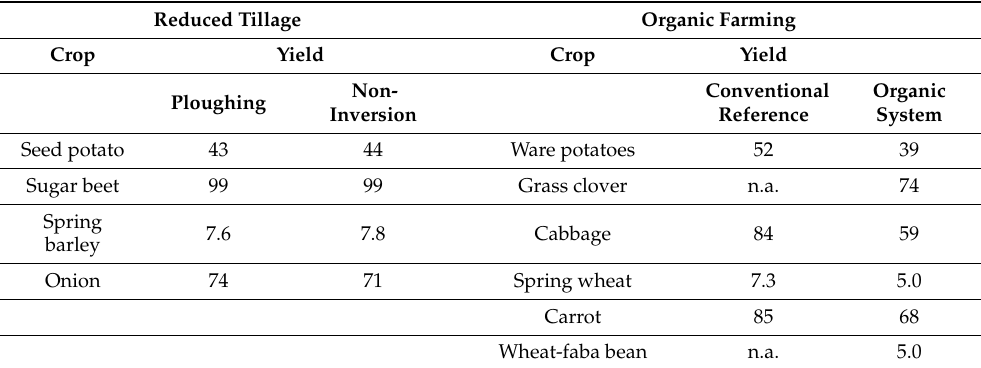
Table 2. Crop yields in tons of fresh product/ha for conventional ploughing and non-inversion tillage and crop yields for conventional and organic farming both derived from BASIC experiments. Average yields over the period of 2009–2018. Conventional reference based on [12]. Reduced Tillage Organic Farming Crop Yield Crop Yield Non- Conventional Organic Ploughing Inversion Reference System Seed potato 43 44 Ware potatoes 52 39 Sugar beet 99 99 Grass clover n.a. Spring barley